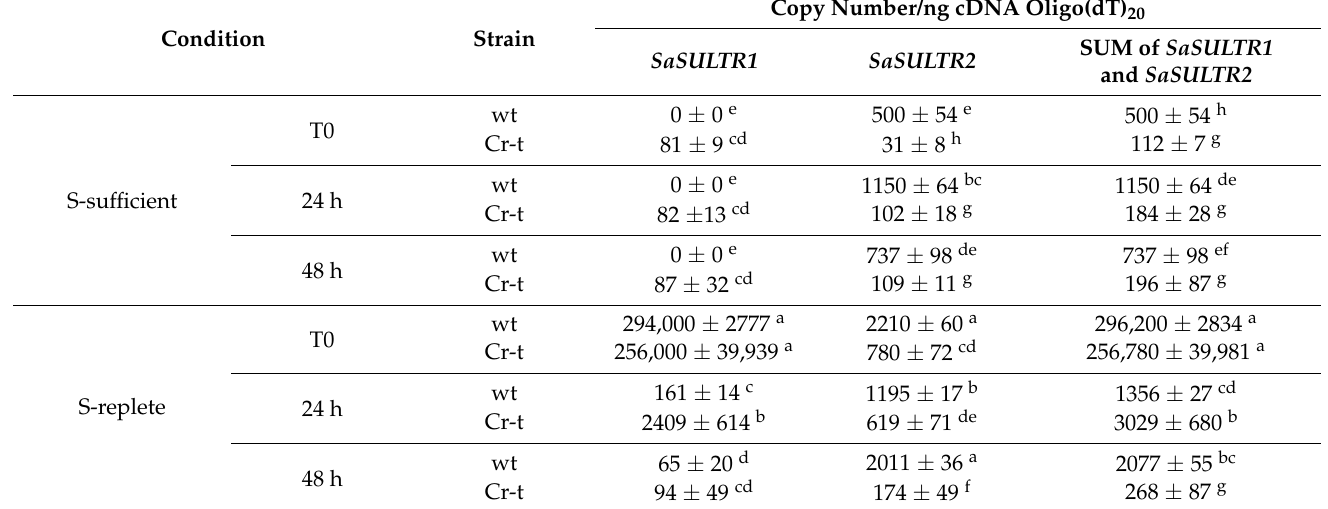
Table 1. Copy number/ng cDNA oligo(dT) 20 encoding SaSULTR2 and SaSULTR1 transporter in untreated cells in T0 and after 24 and 48 h from medium renewal. Statistical analysis was performed within the column by using one-way ANOVA with the Tukey post hoc test after the Shapiro-Wilk normality test. Data are reported as mean value ± standard deviation. Different letters label significant different values ( p <